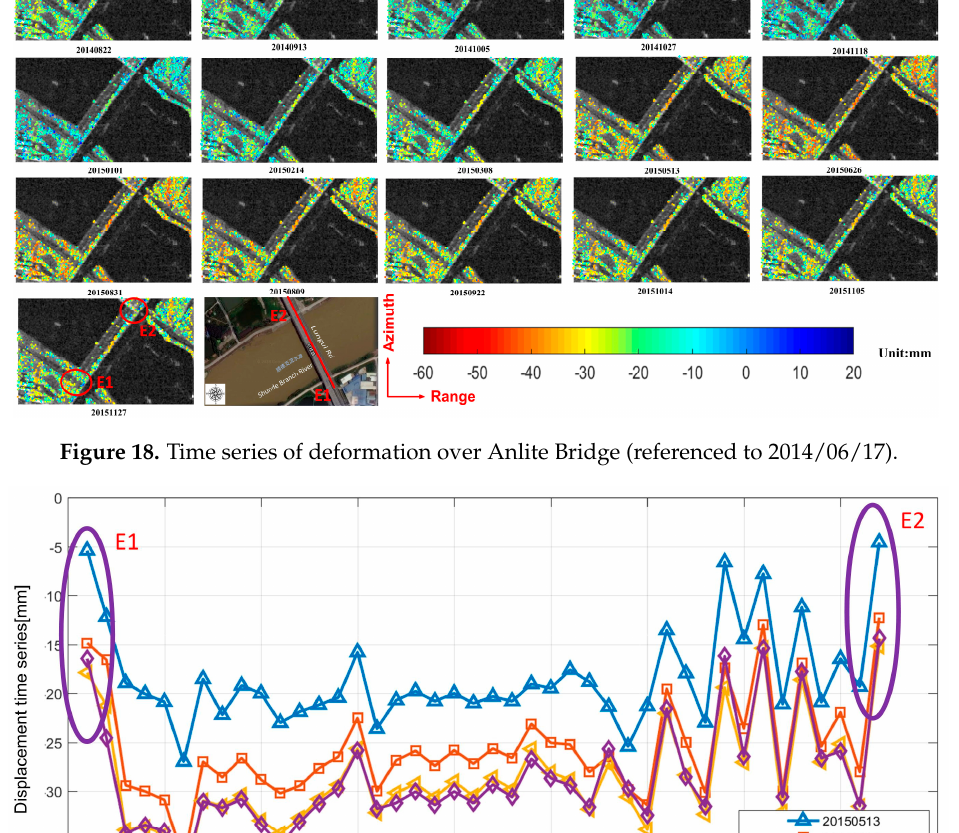
Figure 19. Longitudinal direction displacement analysis along E1E2 on Anlite Bridge.